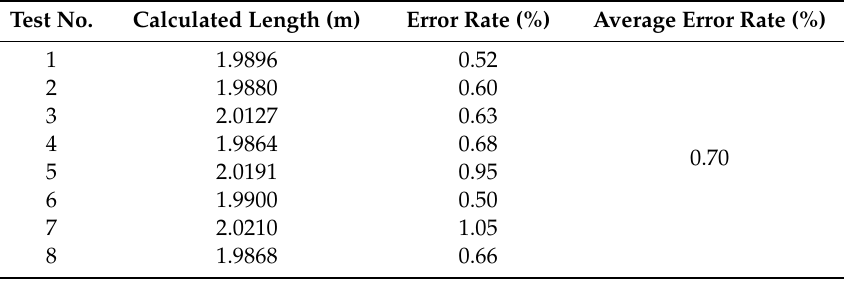
Table 5. Di ff erent depth test results of the 2.00 m buried metal